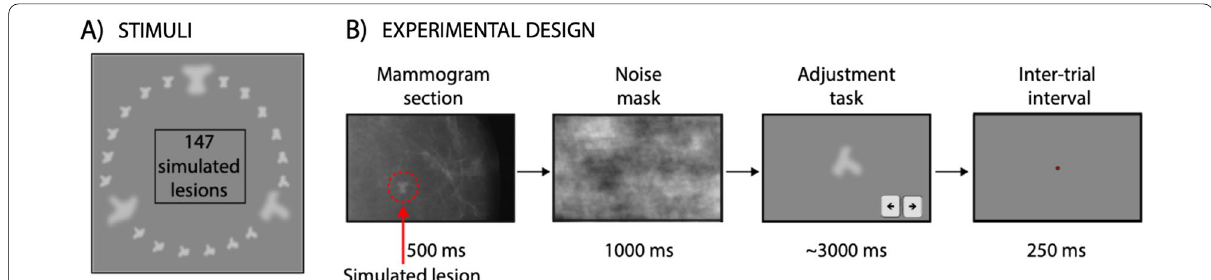
Fig. 1 Stimuli and design of the Experiments 1 and 2. A We created three objects with random shapes (prototypes A / B / C , shown in a bigger size) and generated 48 morph shapes in between each pair (147 shapes in total). We used these shapes as simulated lesions during radiological screening. B Observers were presented with a random shape (simulated lesion) hidden in a mammogram section, followed by a noise mask. Radiologists were then asked to adjust the shape to match the simulated lesion they previously saw, and pressed spacebar to confirm. During the inter‑trial‑interval, a red fixation dot appeared in the center. The size of the shape adjustment is identical to the size of the simulated lesion, but it was enlarged for illustrative purposes. After a 250 ms inter‑trial interval, the next trial